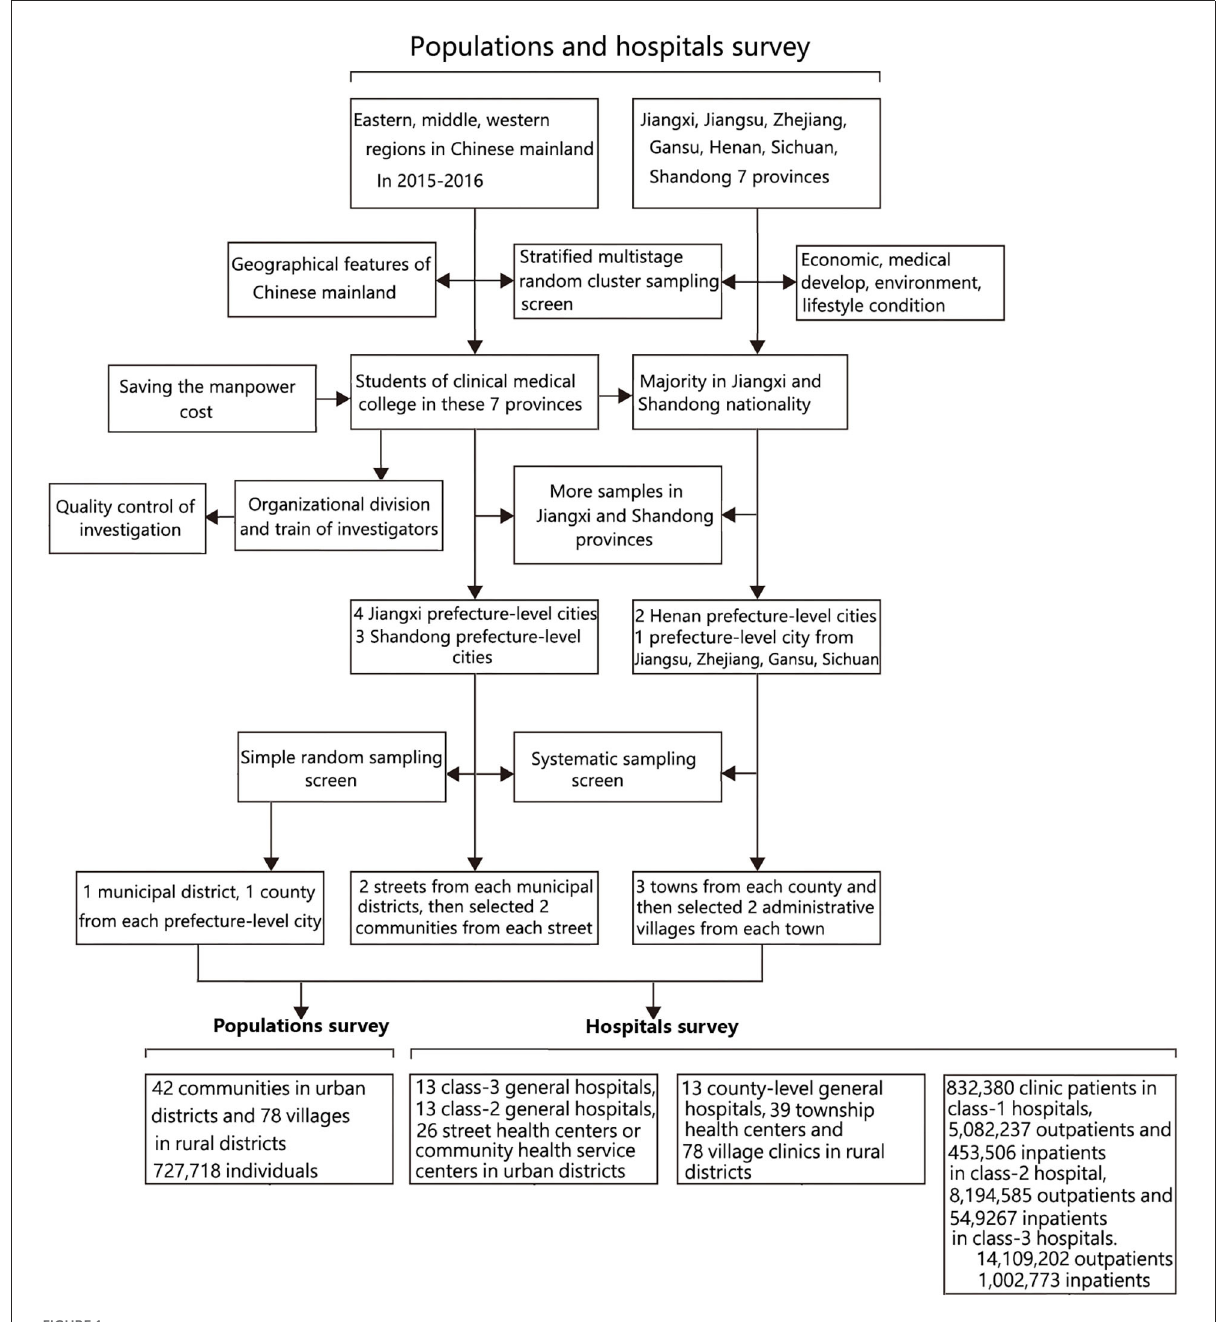
FIGURE1 Selection of participants for population and hospital